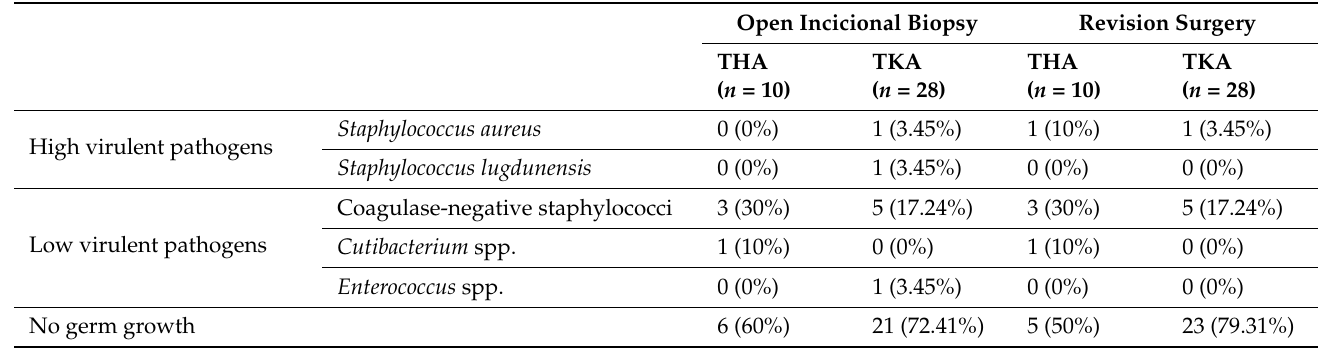
Table 2. Microbiological results of the